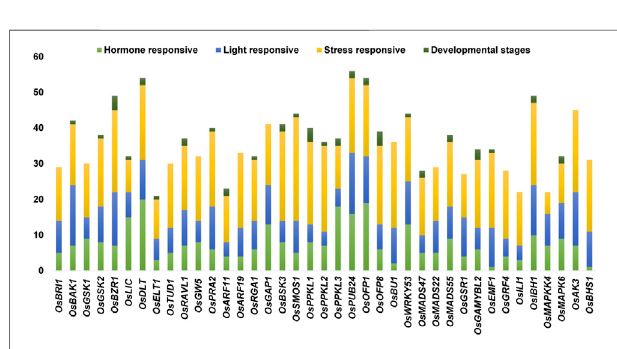
FIGURE 5 | Different categories of cis-regulatory elements according to their biological